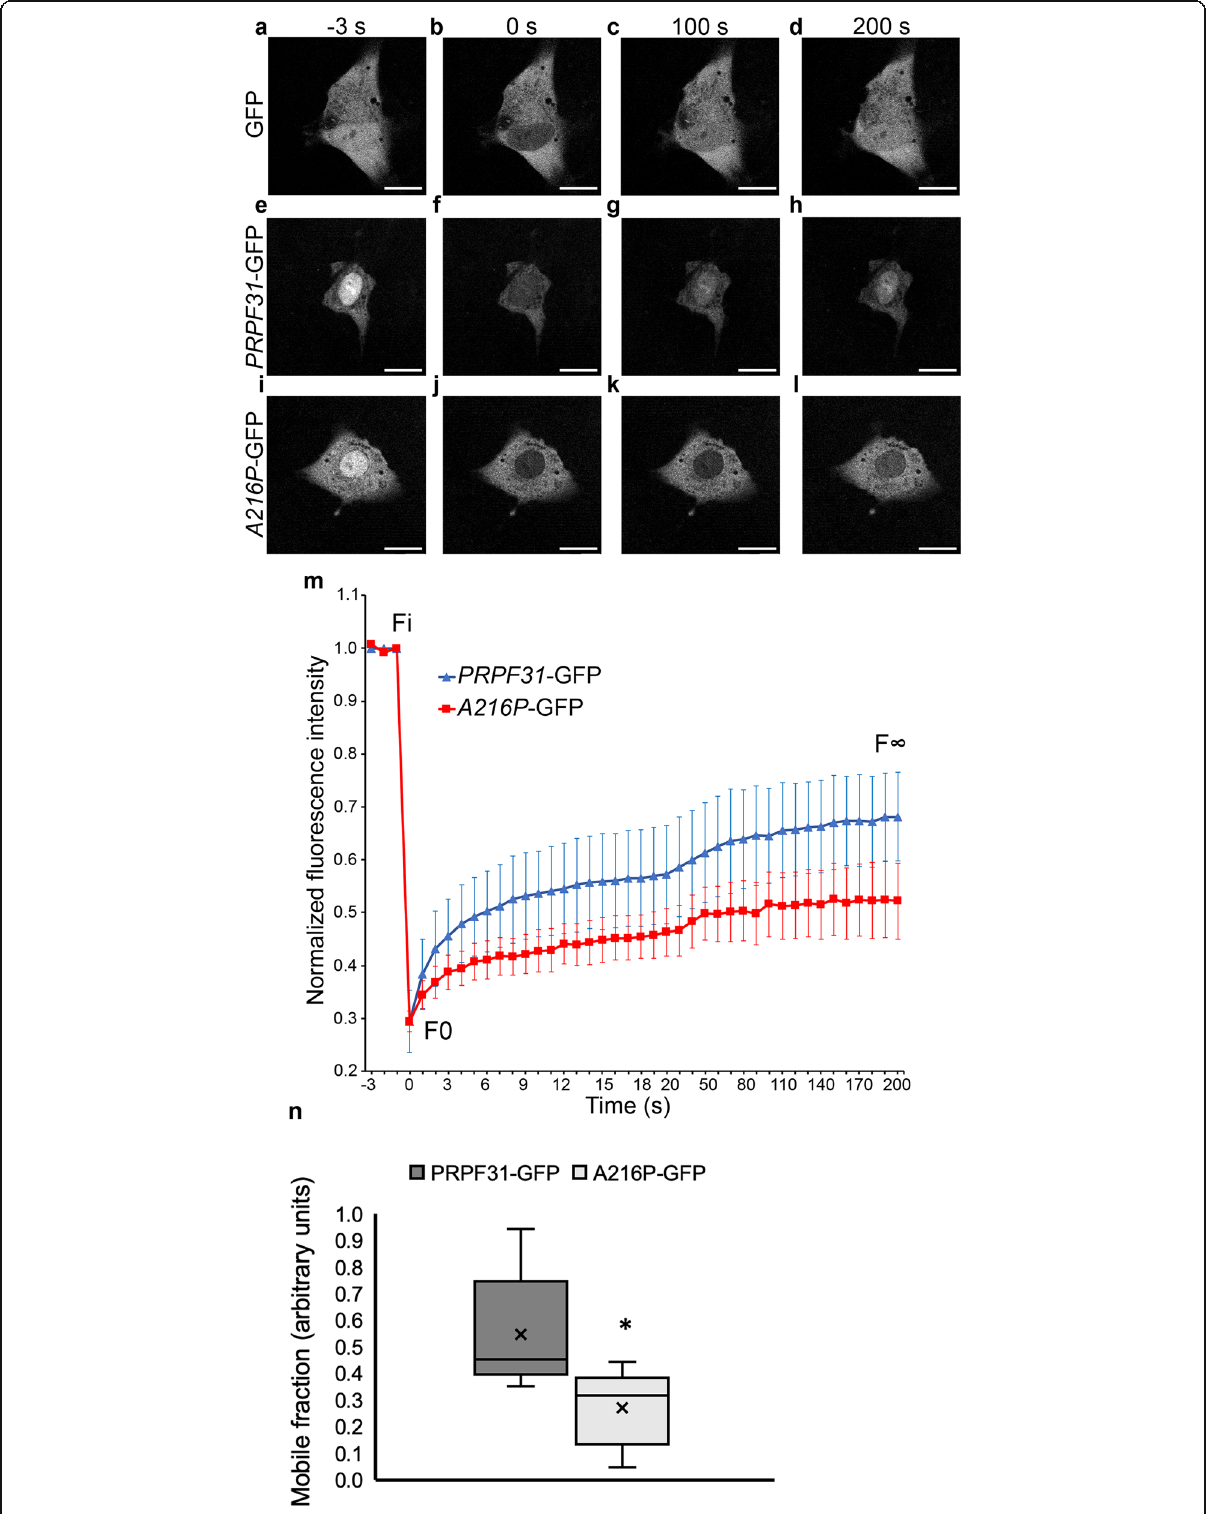
Fig. 8 (See legend on next